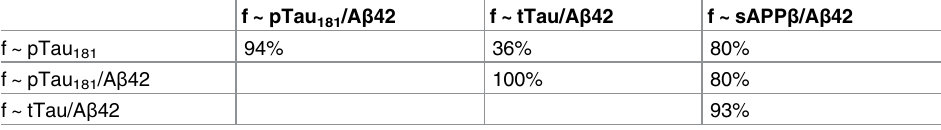
Table 9. The percent overlap between the significant finding maps using the FWE-DTI f -value. f ~ pTau 181 /A β 42 f ~ tTau/A β 42 f ~ sAPP β /A β 42 f ~ pTau 181 94% 36% 80% f ~ pTau 181 /A β 42 100% 80% f ~ tTau/A β 42 93% These are computed as the percent of the smaller map, which overlaps with the larger